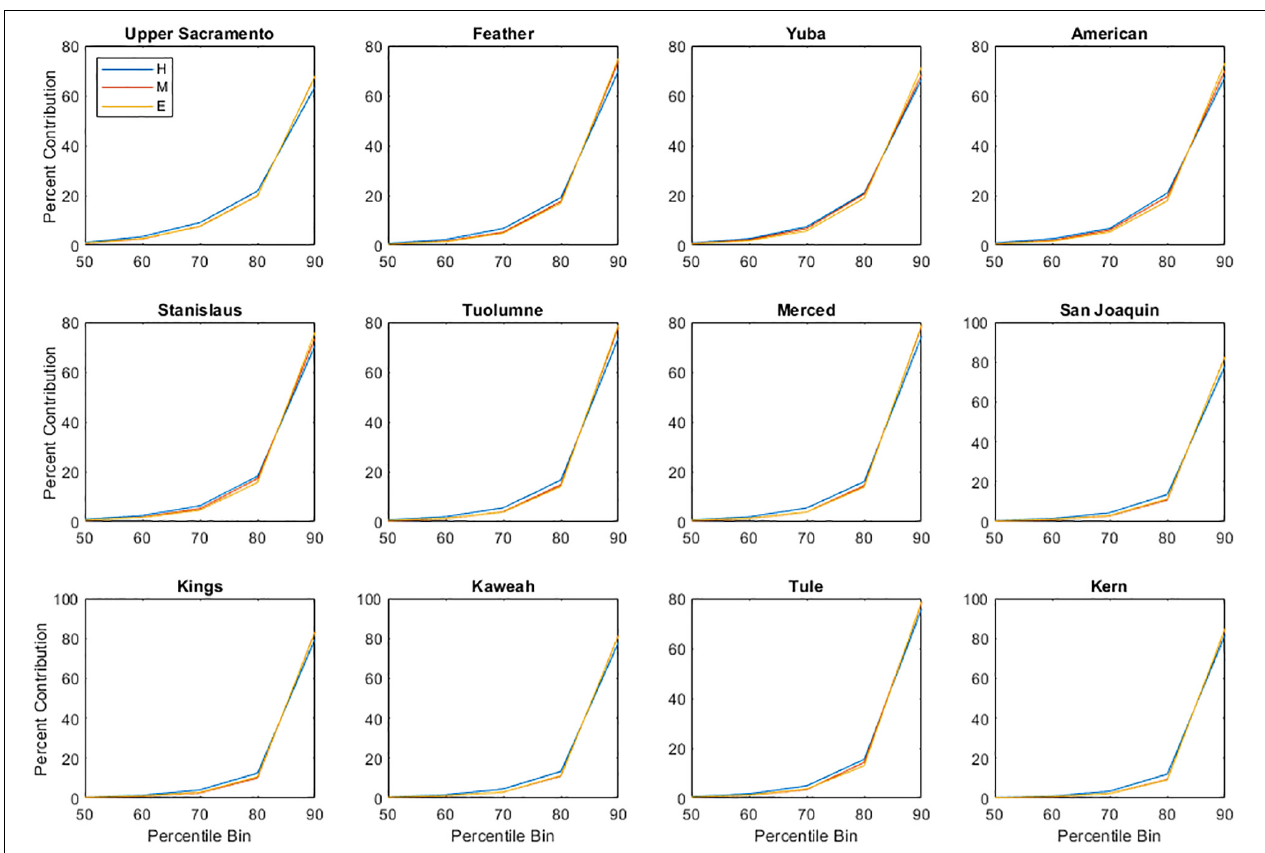
FIGURE 11 | Percent contribution of precipitation within each percentile bin to total precipitation, accumulated across each decade, for each Sierra Nevada basin. Percentile bins < 50th are not shown due to their small contribution to total precipitation. Basins are sorted from north (Upper Sacramento) to south